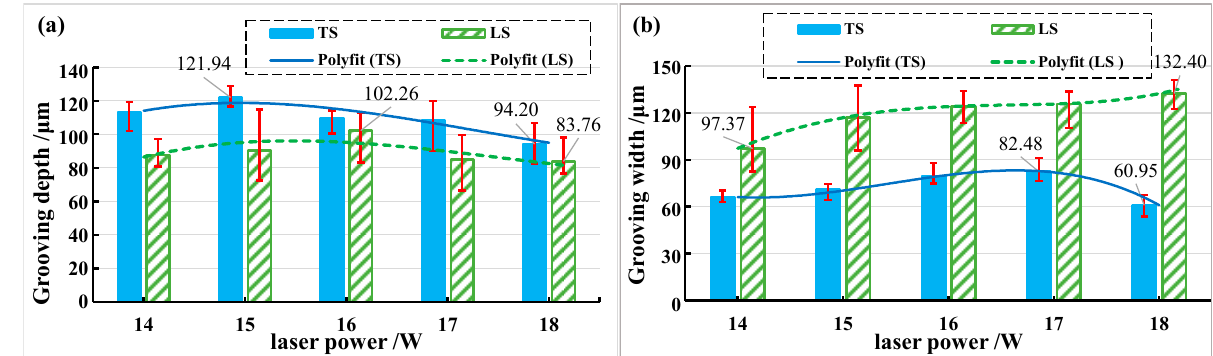
Figure 15. The change in grooving depth and width with increasing laser power in different feeding directions. ( a ) Grooving depth; ( b ) grooving width. 3.2.3. Influence of Different Laser Frequencies on the Grooved Morphologies The grooved morphologies corresponding to different laser repetition frequencies are shown in Figure 16 when the fiber longitudinal arrangement and laser transverse scanning. The recasting layer of the grooved surface is relatively flat when the repetition frequency is less than 10 kHz. The recasting layer of the grooved surface is more uneven, and the tooth shape is obvious when the repetition frequency is greater than or equal to 10 kHz. The recasting layer of the grooved surface is irregular, and a part of the fibers is not removed when the repetition frequency is 12 kHz.